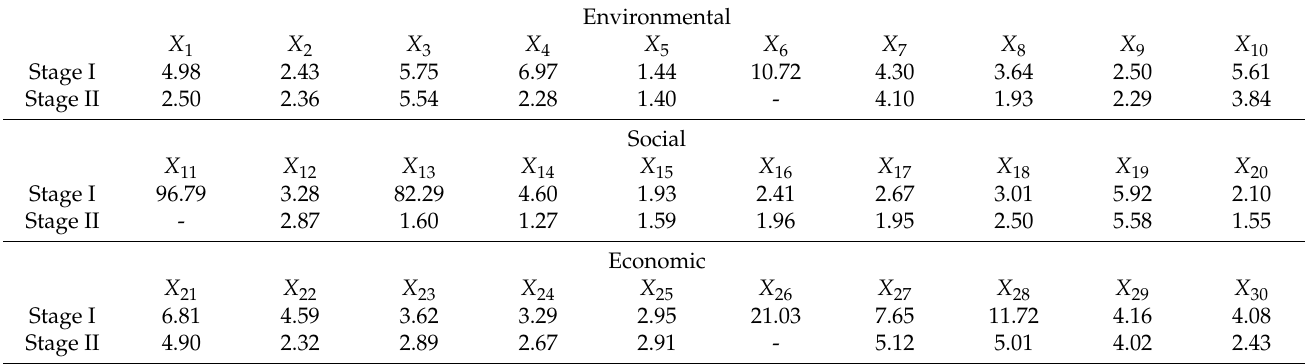
Table 3. Main diagonals of inverted matrices of Pearson’s correlation